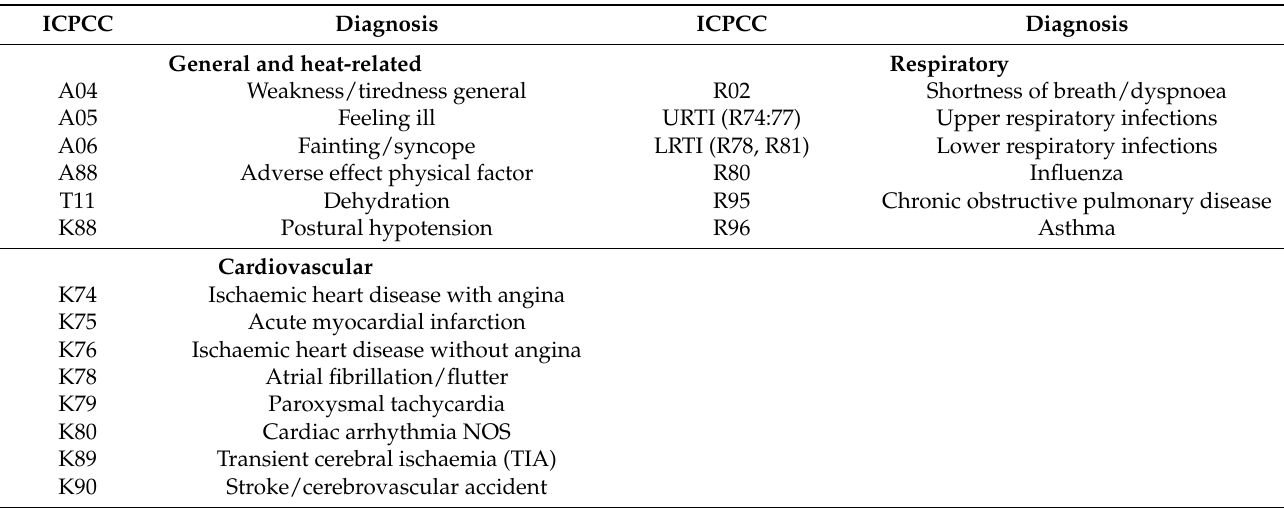
Table 1. List of morbidities studied along with their corresponding ICPCC2